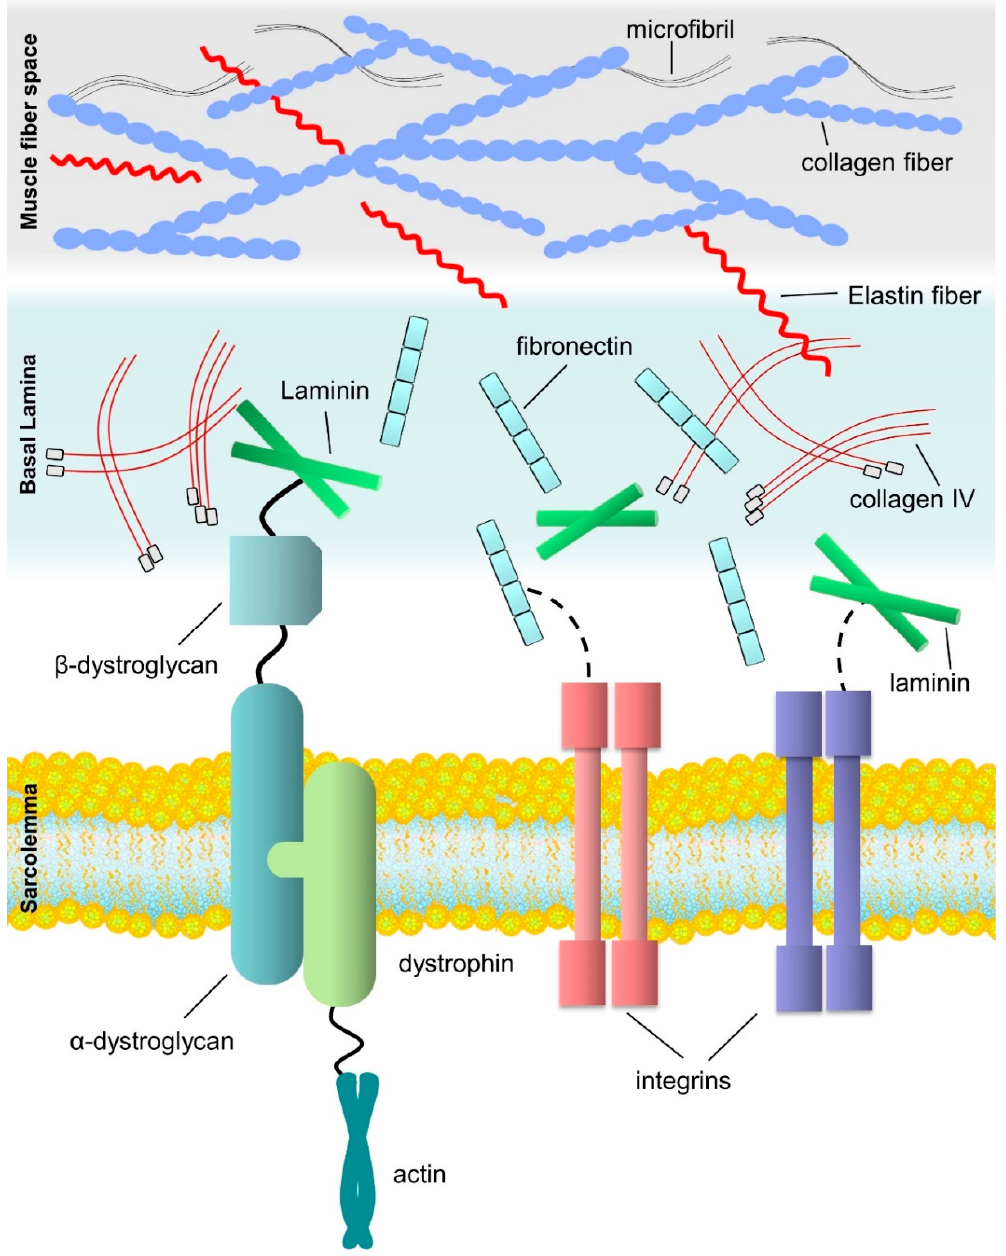
Figure 1. Schematic representation of the extracellular matrix environment (muscle fiber space), basal lamina, and sarcolemma of skeletal muscle.